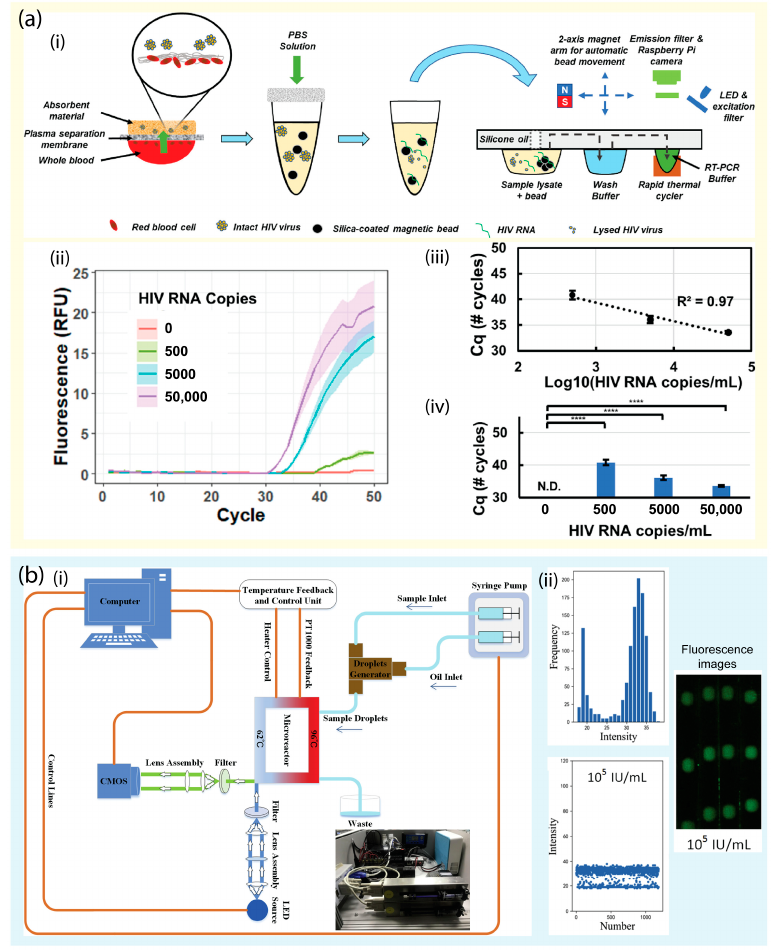
Figure 6. ( a ) Schematic representation of the POC HIV virus. (i) Working principle of the microdevice operation for HIV detection. (ii) Amplification curves. (iii) Cq values. (iv) LOD evaluation at 500 HIV RNA copies/mL. N.D. stands for non-detected. **** indicates p < 0.0001. Reprinted with permission from [88]. Copyright (2022) ACS publications. ( b ) A fully integrated continuous- fl ow digital PCR device for hepatitis B detection. (i) Schematic representation of the system of continuous- fl ow digital PCR instrument. (ii) The digital PCR detection results: the distribution, frequency, and real image of the fl uorescence intensity of the droplets. Reprinted with permission from [90]. Copyright (2020) Elsevier.